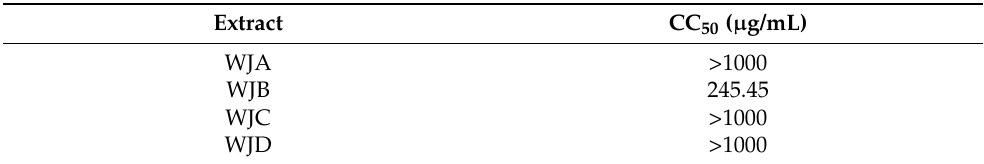
Figure 1. Fibroblast viability (BJ cell line ATTC CRL-2522 TM ) after a 24-h incubation with the WJA, WJB, WJC, and WJD extracts. * Significantly different results compared to the control (culture medium without extracts—0 µ g/mL), unpaired t -test; p < 0.05. Table 7. The half-maximal cytotoxic concentrations (CC 50 ) of the tested extracts. The CC 50 values were determined against normal human skin fibroblasts (BJ cell line ATTC CRL-2522TM) after a 24-h